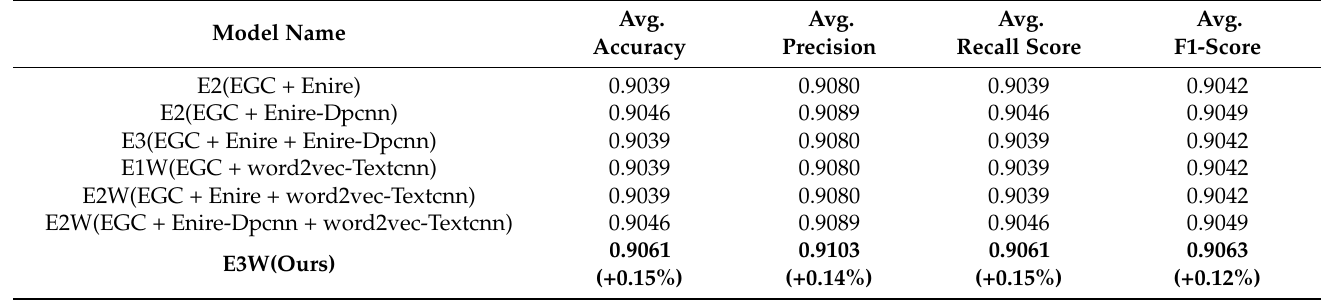
Table 7. Ablation experiments on E3W, with the best experimental results in bold and the number in brackets representing the comparison of the current model with the previous best